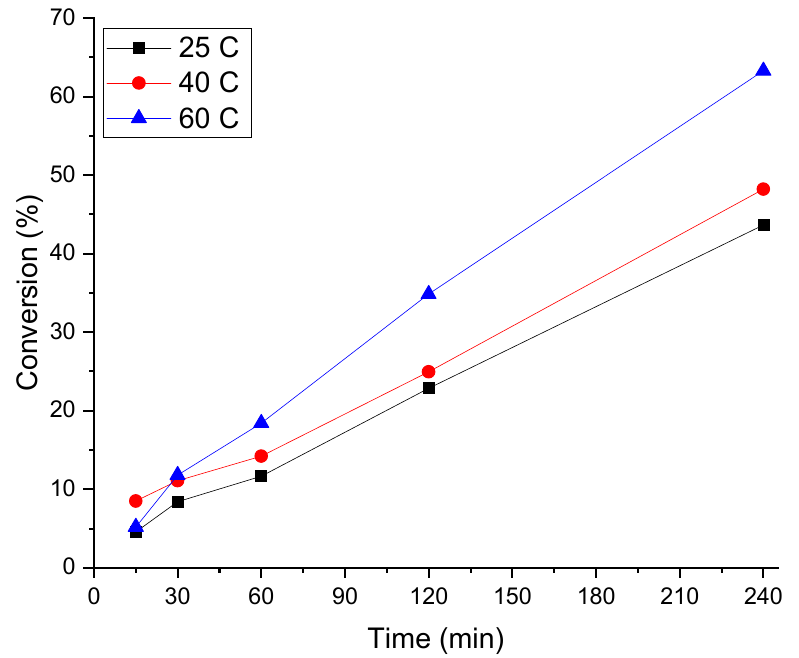
Figure 5. Effect of temperature on FA decomposition over 1%Ir:2%Pd/C. Reaction conditions: FA (0.5 M), catalyst (substrate:metal molar ratio = 2000:1), 700 rpm, and 240 min.